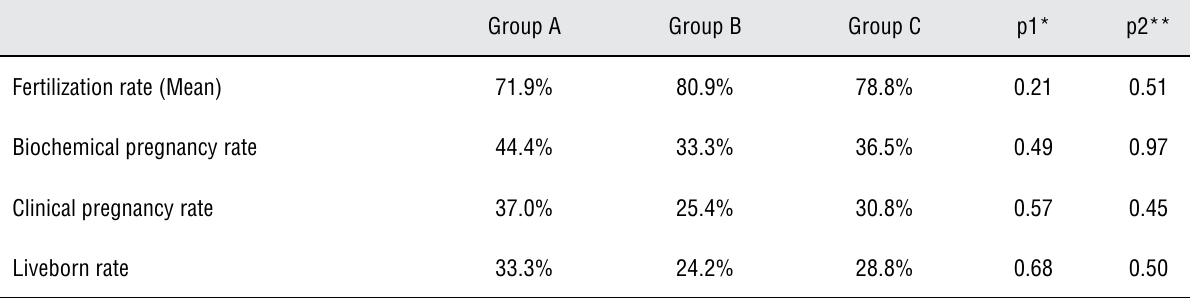
Table 2 - Fertilization and pregnancy rates in the groups and p value for statistical comparison of groups A and B to group C.